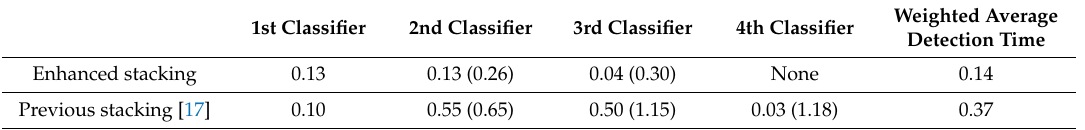
Table 5. Comparison of the detection time (accumulated time) of the component classifiers (sec /